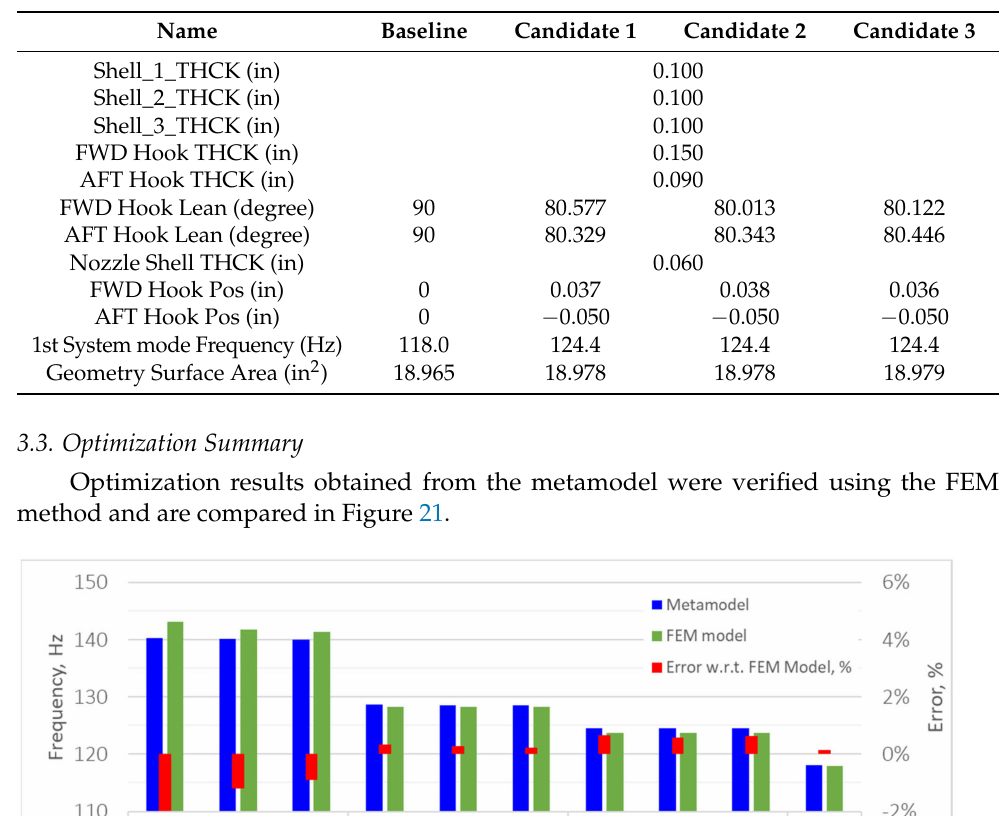
Table 7. Optimization results—Objective function J 2B